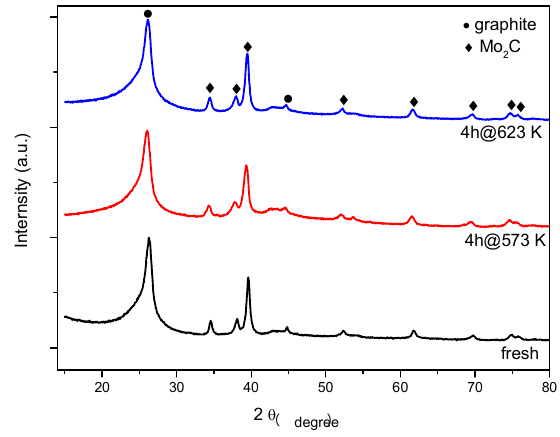
Figure 7. X-ray diffraction patterns of fresh and spent catalysts after 4 h reaction tests at 573 and 623 K. Table 2. Mo 2 C crystallite size of the fresh and spent catalysts determined by X-ray Diffraction